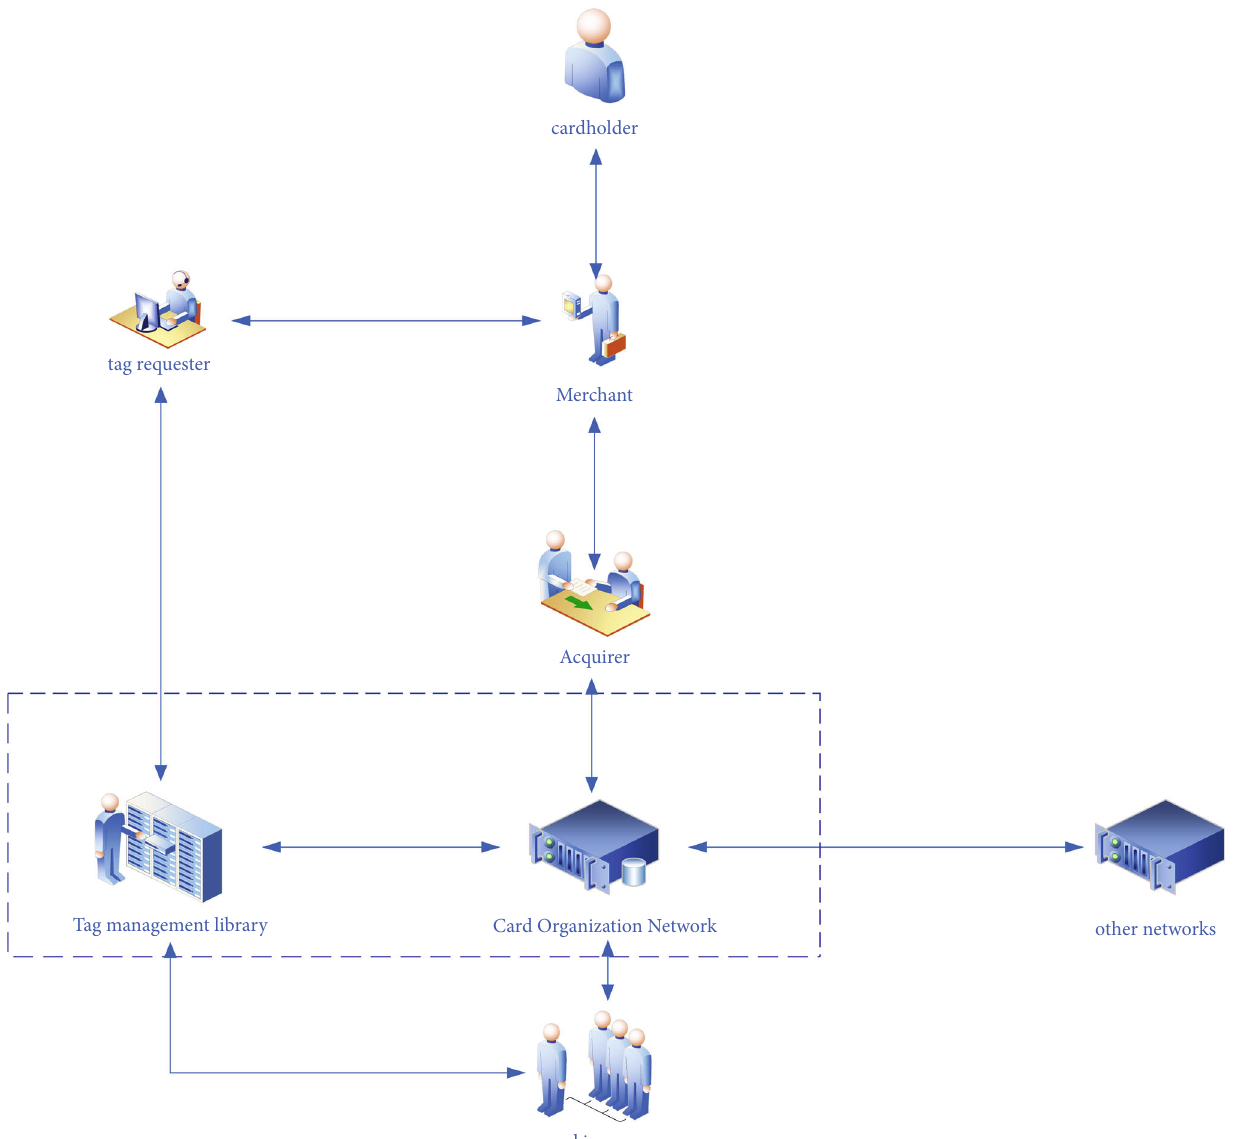
Figure 1: Payment markup